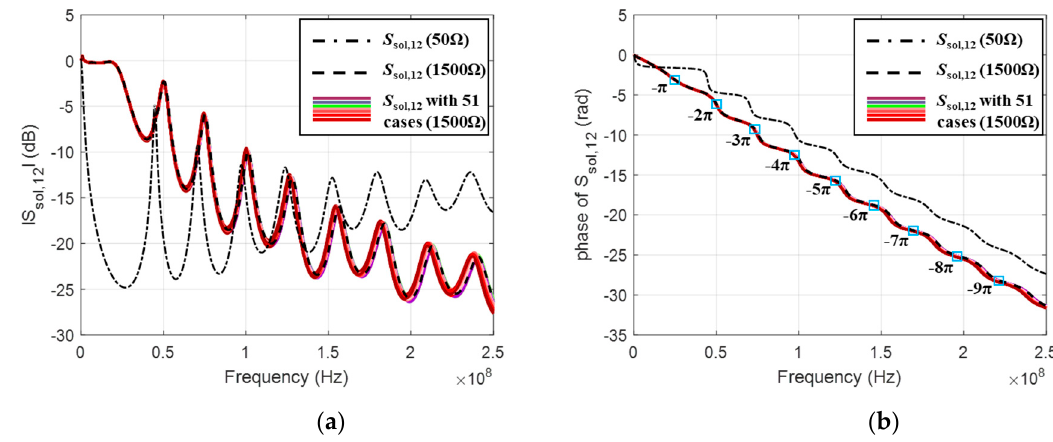
Figure 8. Transmission parameter of one-layered solenoid, S sol ,12 , referenced to 1500 Ω and 50 Ω . ( a ) Magnitude; ( b ) Phase characteristics. Colored traces are for 55 S sol ,12 data with 1–5 rings installed in the